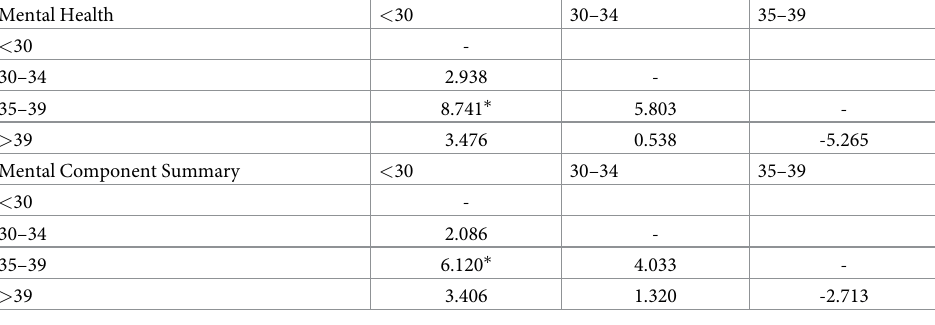
Table 5. Differences in mental health domain and mental component summary by age post hoc